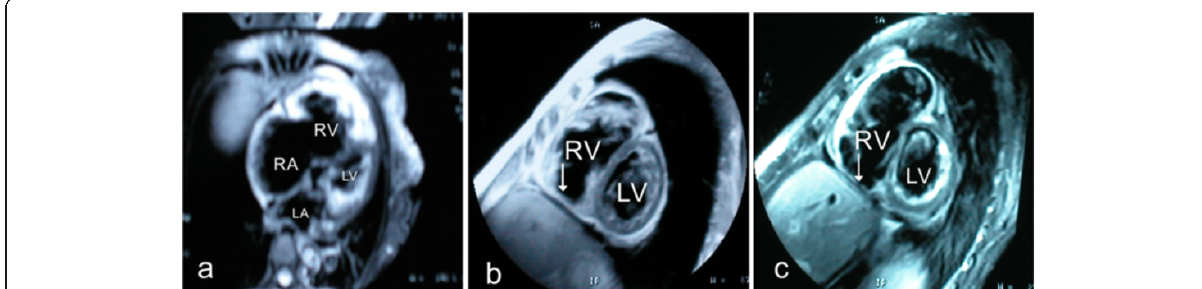
Figure 2 a: The cardiac MRI showed enlargement of right ventricle and atrium without enlargement of left ventricle and atrium; b: the thickness of right ventricle wall and interventricular septum was uneven; high signals indicated fatty tissue replacement (arrows); c: the signals in right ventricule free wall discontinued after inhibiting fatty tissues (arrows).